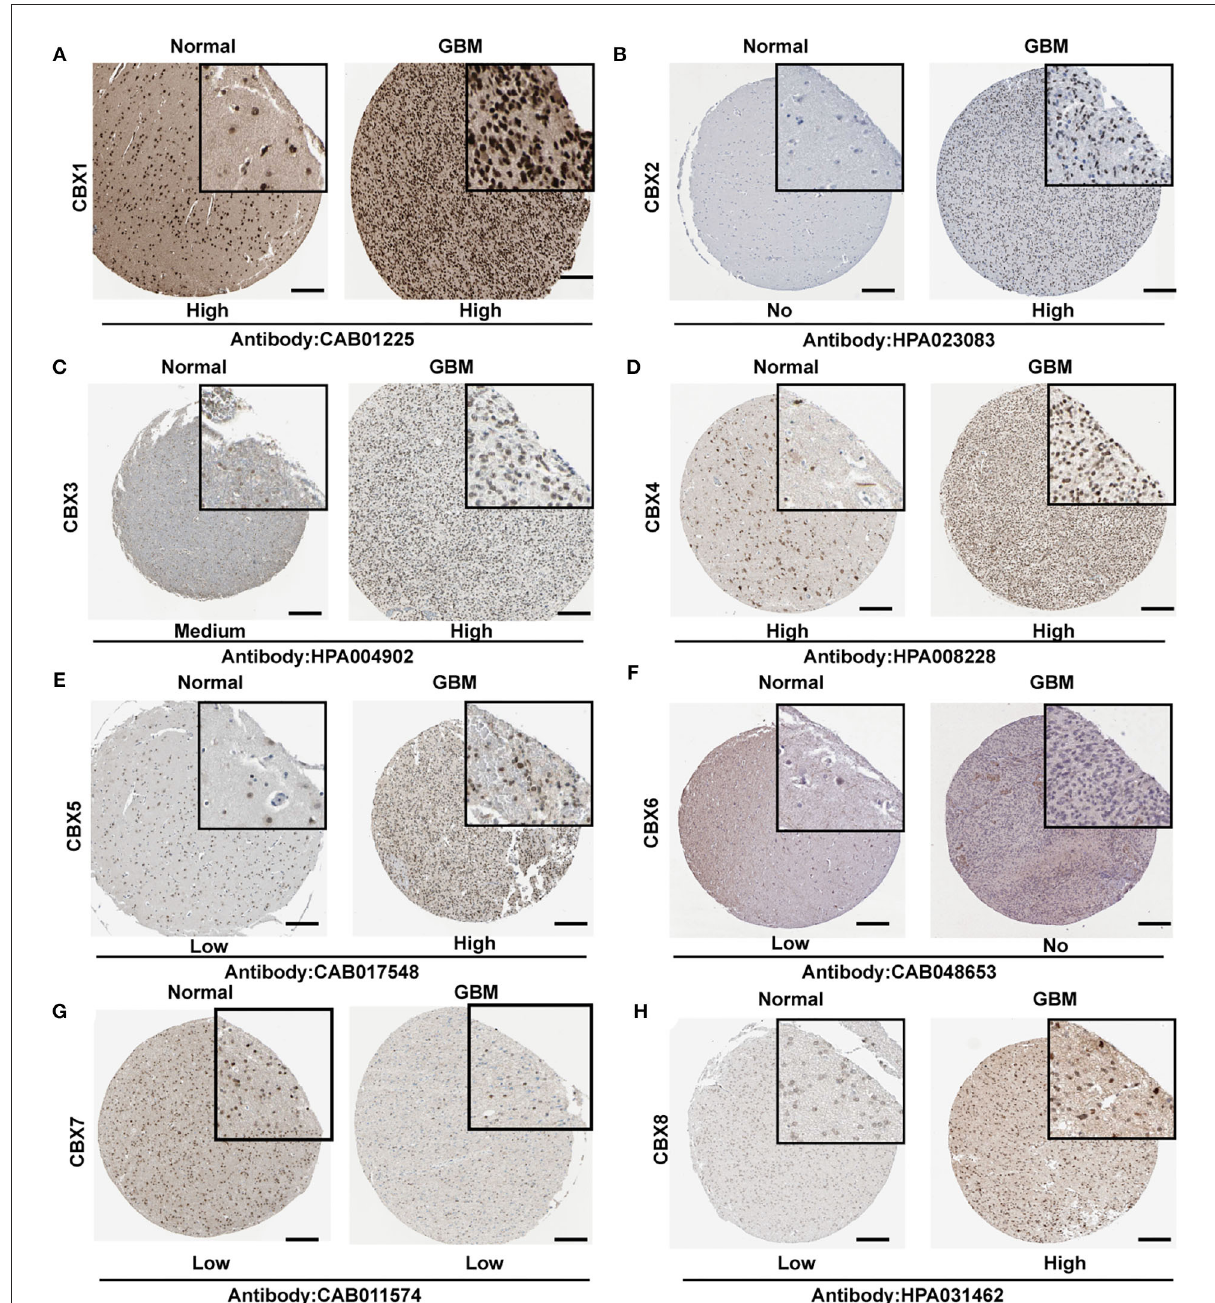
FIGURE3 Representative immunohistochemistry images of CBX family in GBM and normal brain tissues from Human Protein Atlas (HPA). (A–H) The protein expression of each tissue was marked under the image. The scale bar represented 4 µ m, and the image in the black square represented a 4x zoom. The antibody used in the staining was labeled